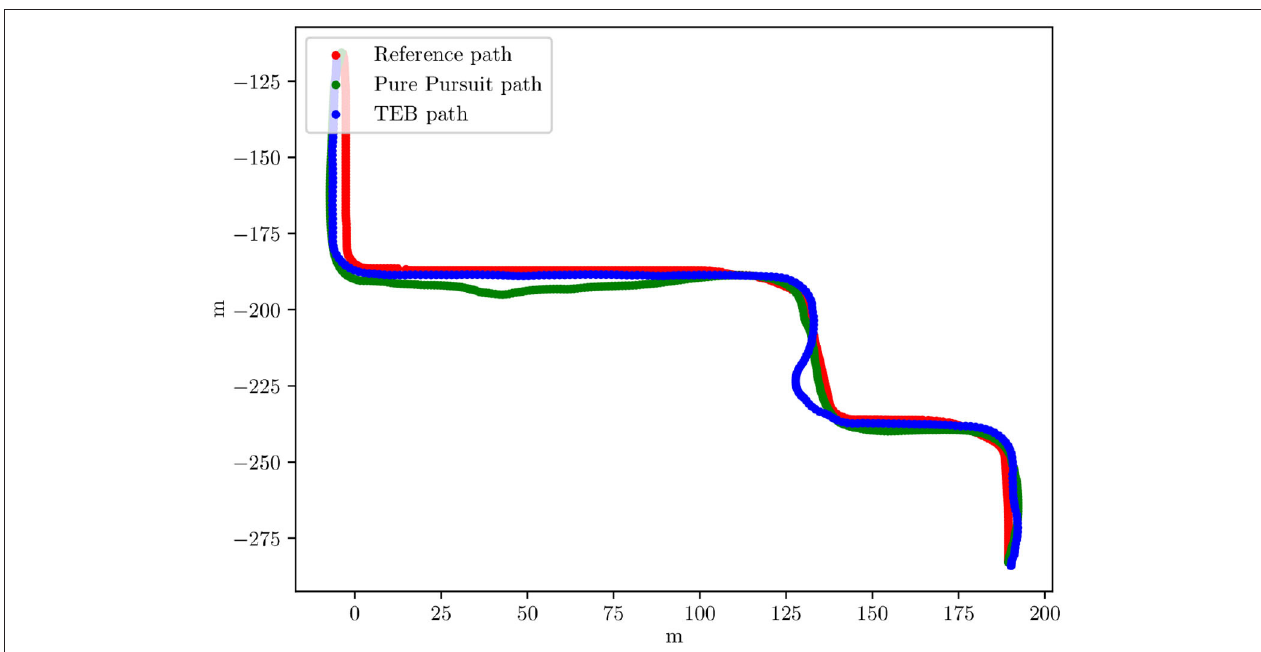
FIGURE 9 | X/Y graph of a track driven in the Carla simulator with pure pursuit and with the TEB planner path. Given in red is the ideal reference path. The X/Y units are meters.